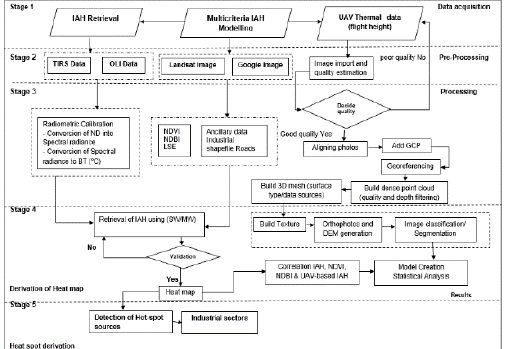
Figure 2. The method flowchart for retrieving